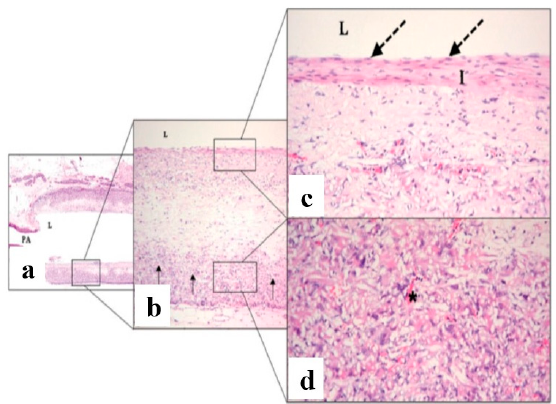
Figure 10. Histological analysis for PCL electrospun blood vessel implanted in an abdominal aortic rat for 12 weeks ( a ) 20 time, ( b ) 100 time, ( c ), and ( d ) 200 time magnification (reprinted from Ref. [31]).